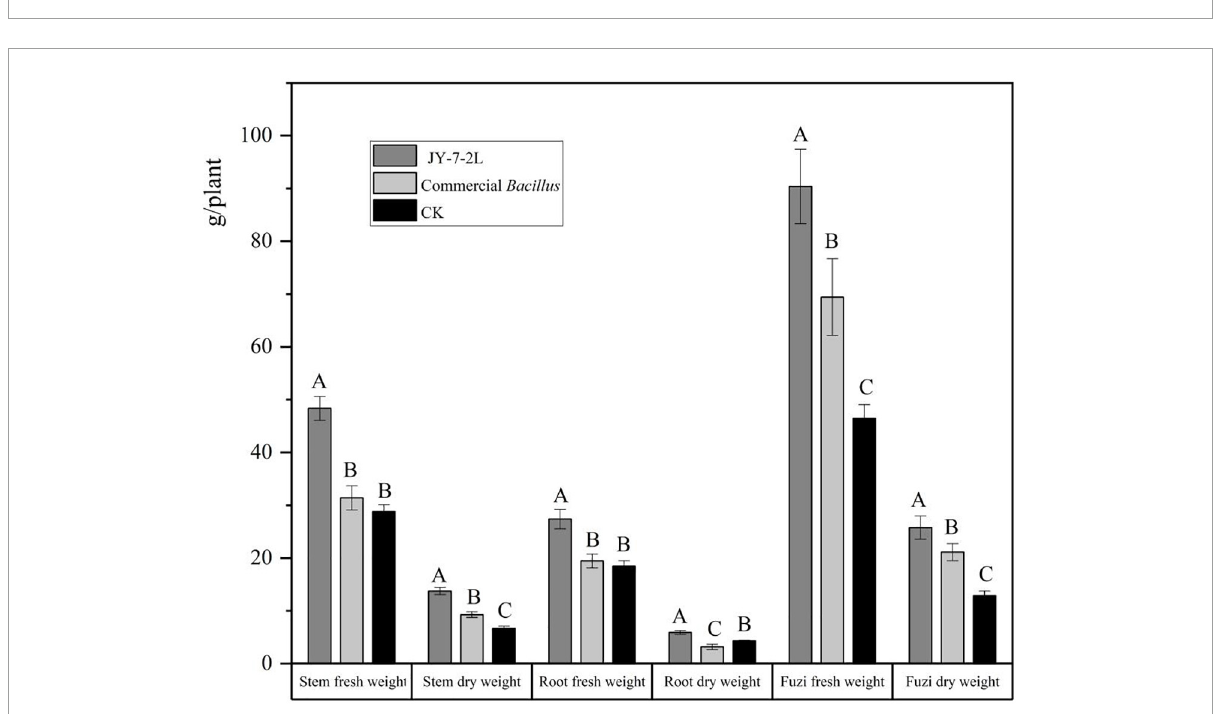
FIGURE9 Effect of JY-7-2L and commercial Bacillus subtilis products on the fresh and dry weight of stem, main root, and lateral root (Fuzi) of Aconitum carmichaelii . The experiment was performed in the Southwest University of Science and Technology (SWUST) field in 2022. Different capital letters indicated significant differences ( p < 0.01) based on one-way analysis of variance (ANOVA) with the least significant difference (LSD)